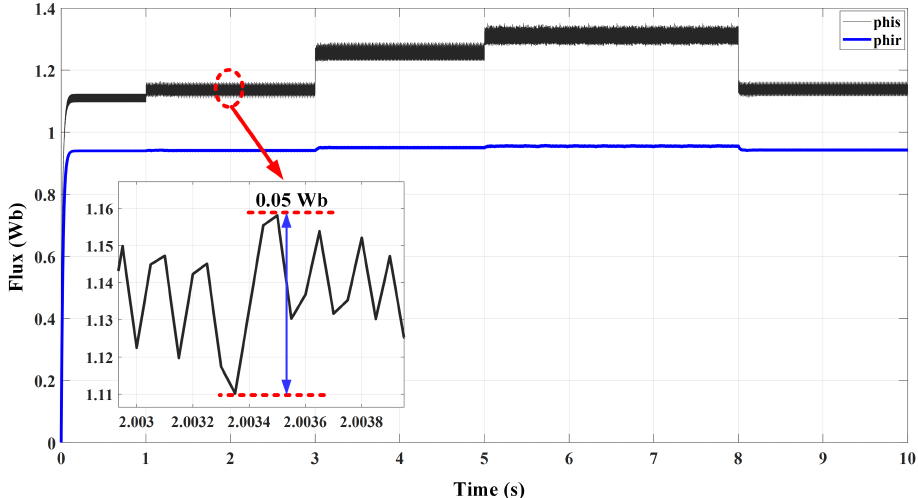
Figure 11. The DTRFC with successive steps of torque reference for stator and rotor flux responses.